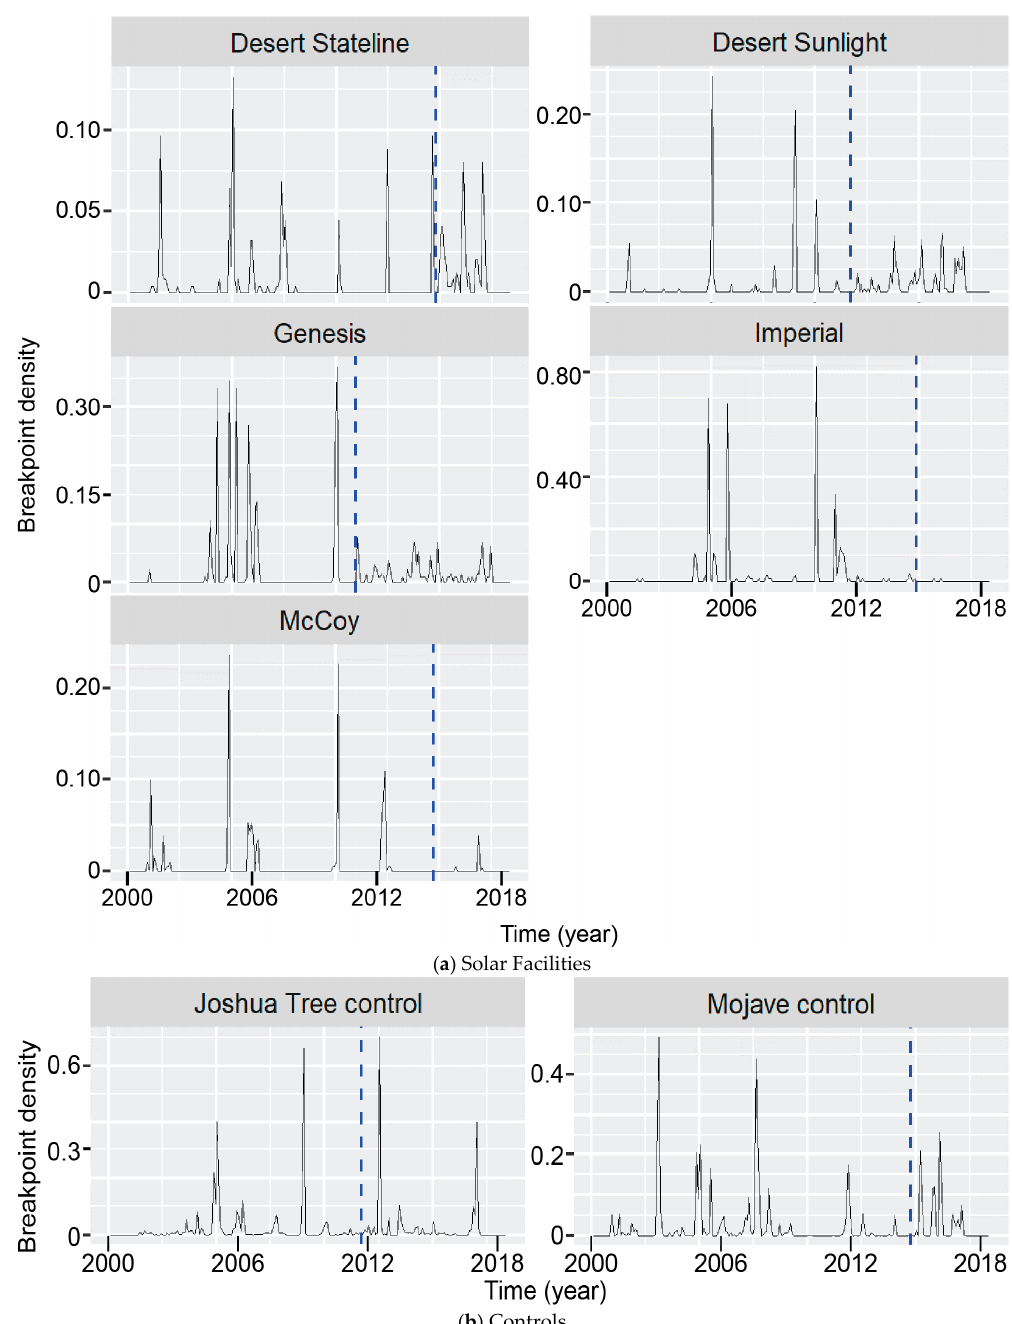
Figure 6. Time series of breakpoint density for solar energy facilities; vertical dashed bars indicate construction start